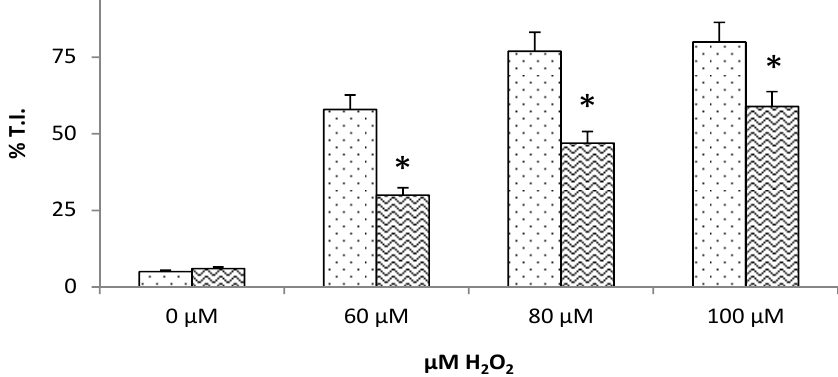
O stress. Cells were stressed with H Figure 6. Comet assay after H 2 2 processed and analysed for DNA damage. The data are expressed as the percentage of intensity fluorescence in the comet tail (percentage tail intensity) in control and pre-treated cells and relate to three independent experiments performed in triplicate. Statistical analysis was performed with T-test. * p < 0.05 significantly different from